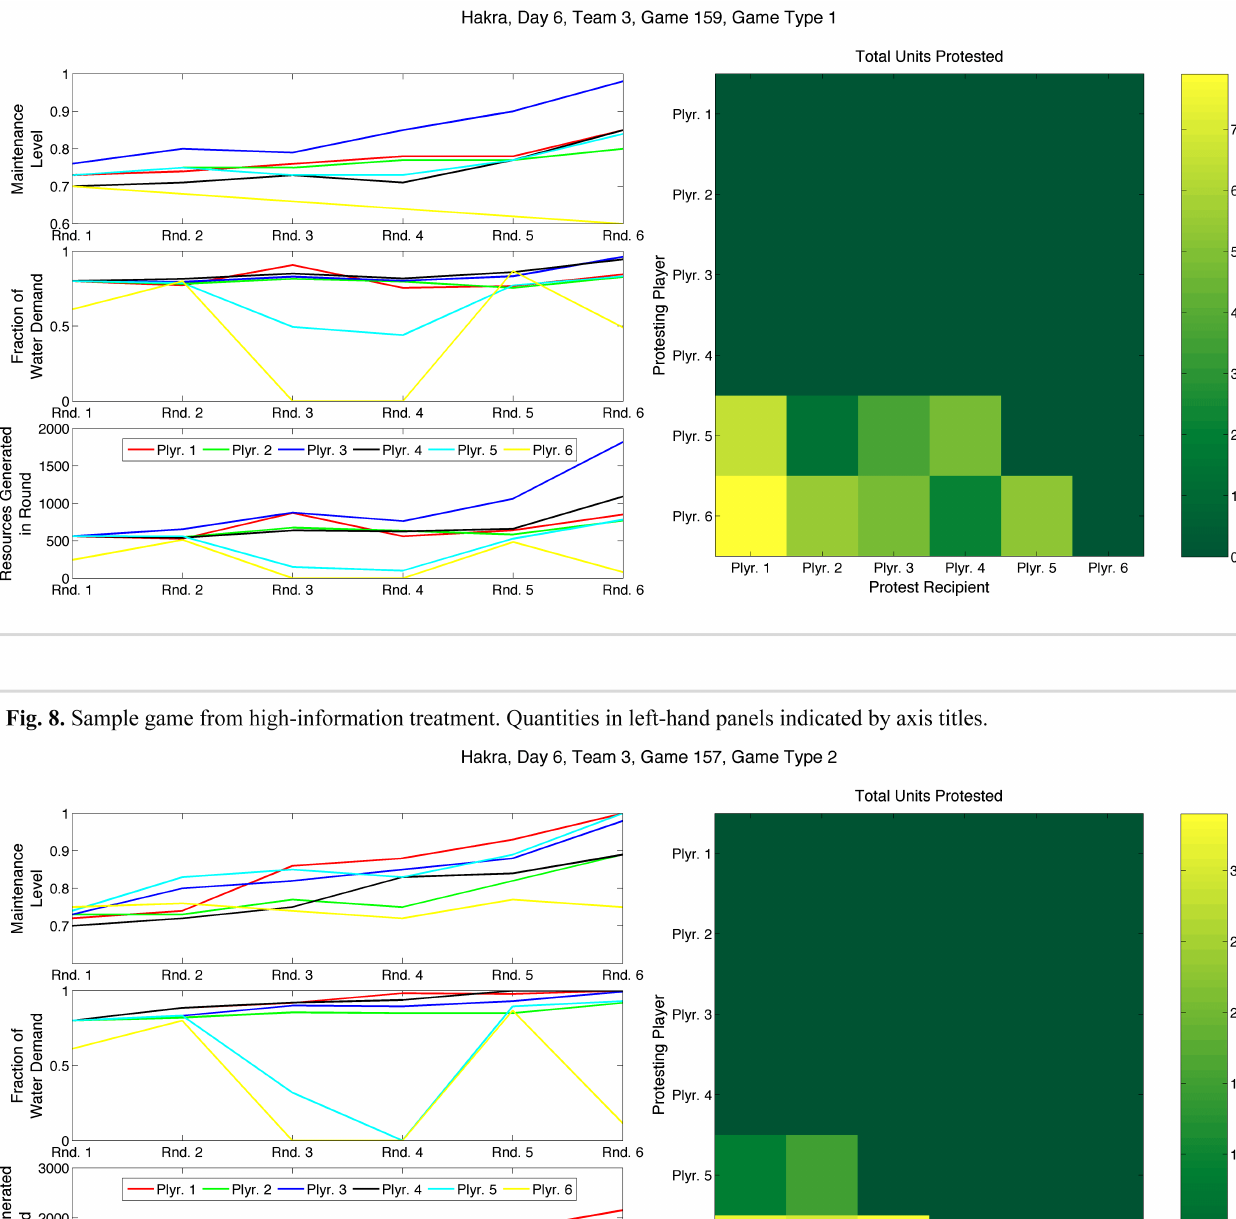
Fig. 7 . Sample game from low-information treatment. Quantities in left-hand panels indicated by axis titles.